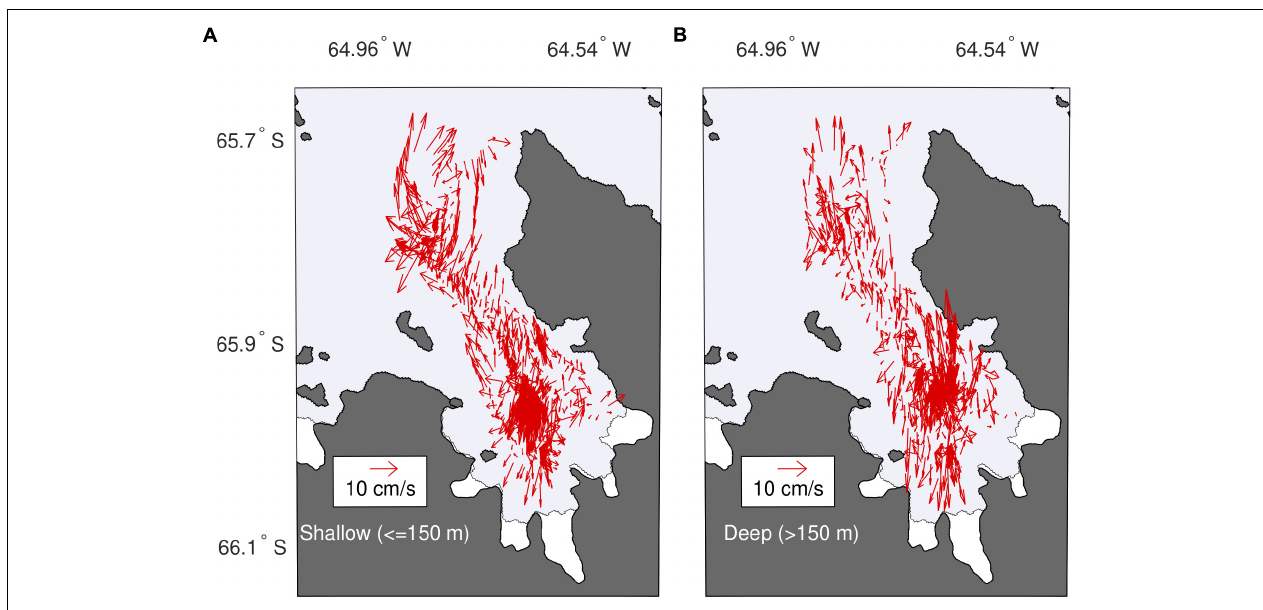
FIGURE 7 | Shipboard ADCP-derived circulation within the bay. Vertically averaged current velocity for the (A) upper 150 m of the water column, and (B) for waters below 150 m. Layer depths were chosen to reflect anomaly patterns shown in Figure 3 .